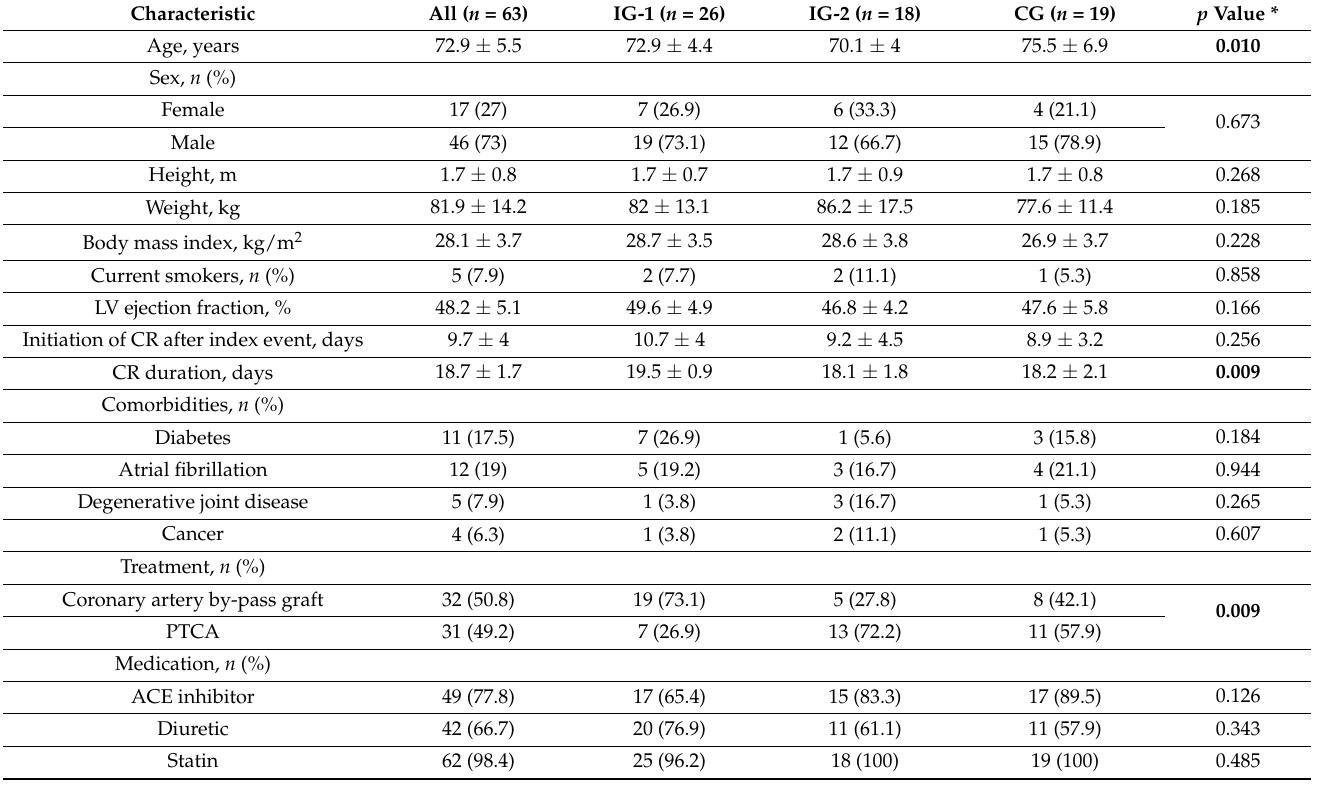
Table 1. Sociodemographic and clinical characteristics of the study